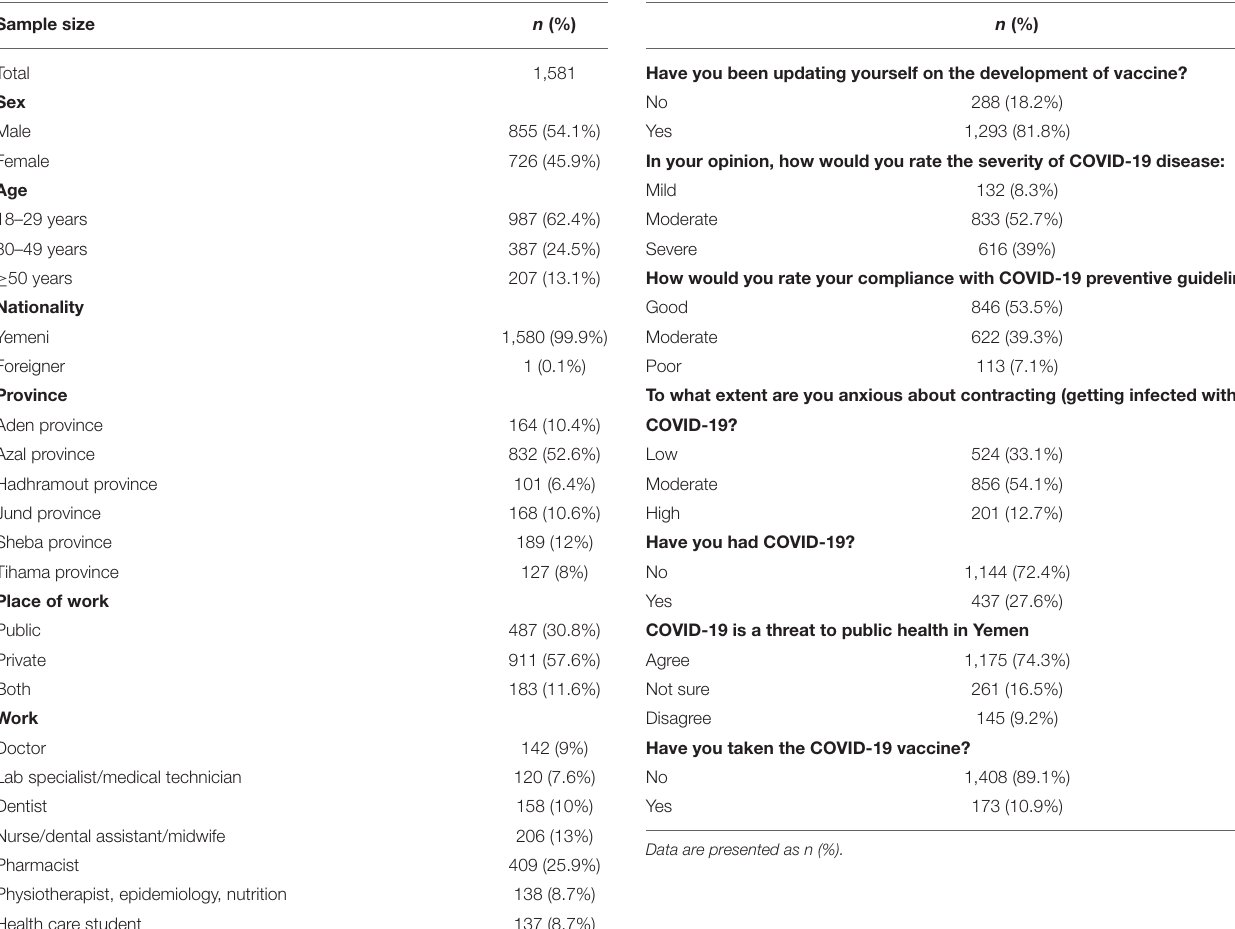
TABLE 2 | Awareness about COVID-19